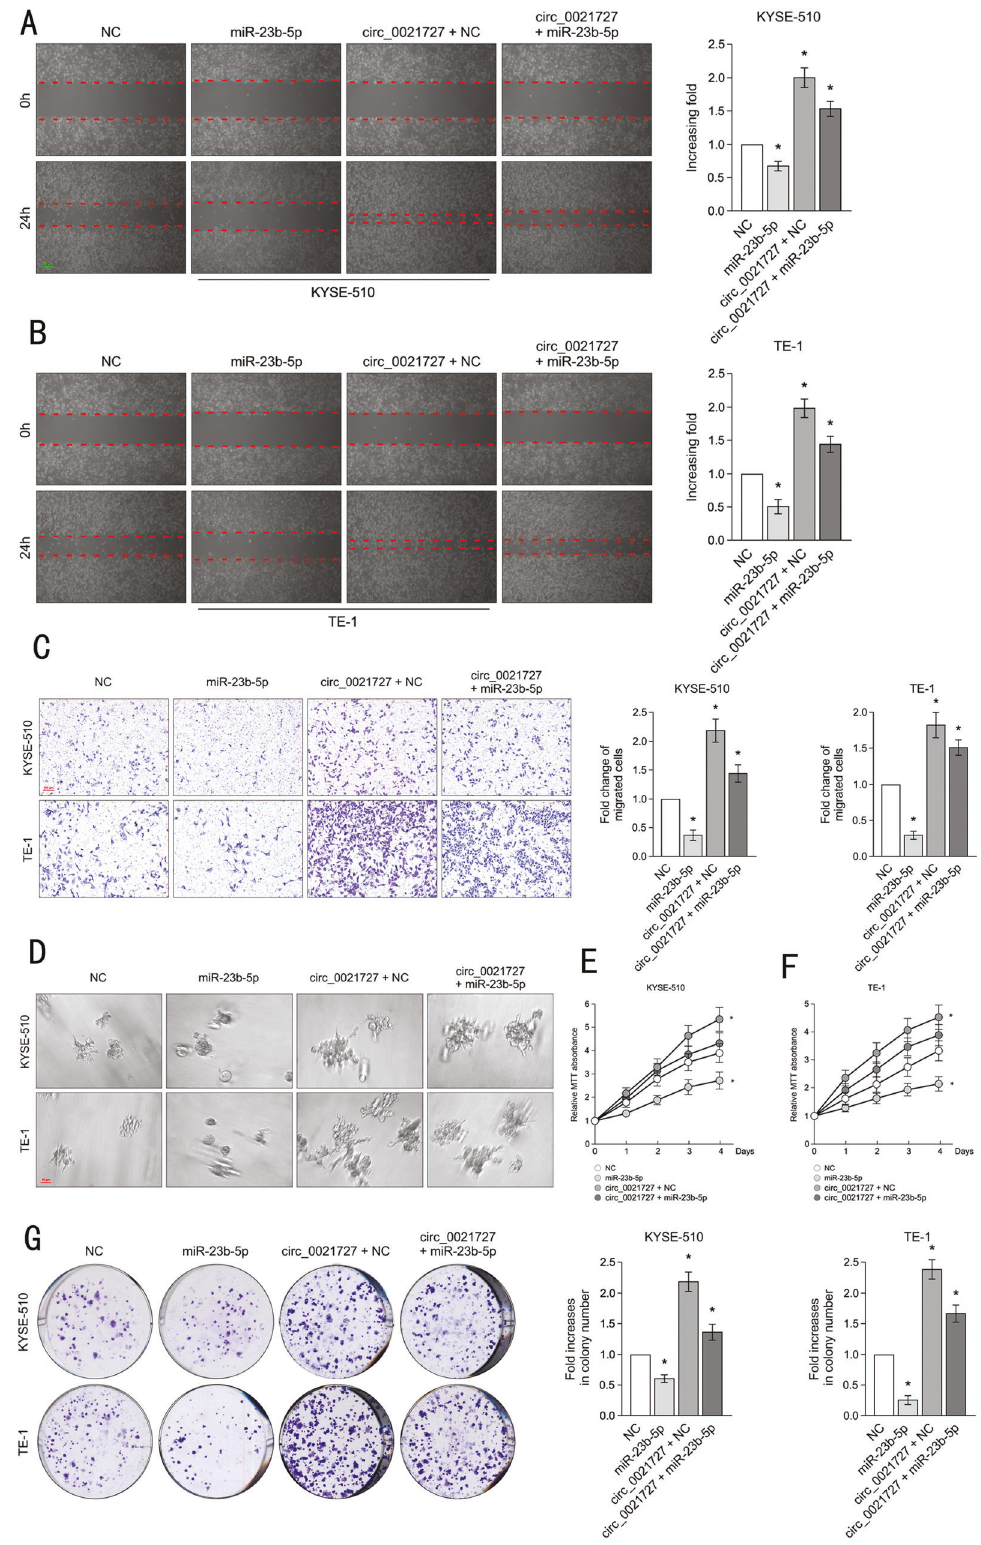
reporter, while miR-23b-5p did not affect the luciferase activity of the TAB1 -MUT reporter (Fig. 7I). Therefore, we believe that miR- 23b-5p could target and bind to TAB1 . To explore the relationship between hsa_circ_0021727, miR-23b-5p, and TAB1, we selected